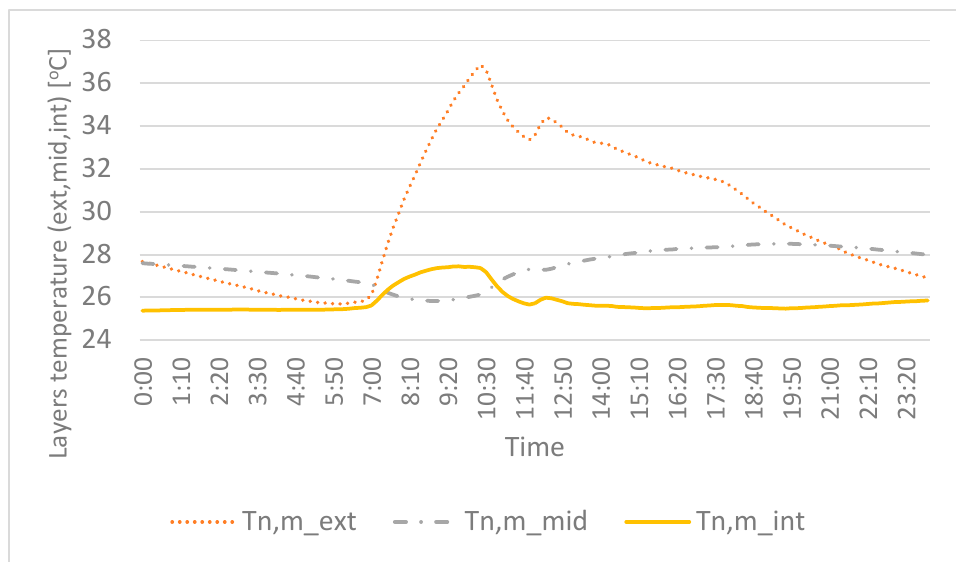
Figure 11. Graph of the average temperature in three layers of the wall on 22 June 2021. The temperature of the outer layer rises during the hours of solar operation on the wall and as the temperature of the outside air increases. Due to the solar gains through the windows, the room temperature also rises, which in turn heats the inner layer of the wall. The increase in temperature of the inner layer is overestimated due to an approximation error during rapid heating of the outer layer. Then the heat is transferred to the middle layer. The temperature increase in this layer is, however, is staggered over time because it is stabilised by the heat capacity of the inner and outer layers. In winter, the average temperature in individual layers is subject to much smaller changes. In the run for 5 January presented in Figure 12, it can be considered constant. Figure 7 shows that the outdoor temperature variation was not greater than 3 ◦ C during the whole